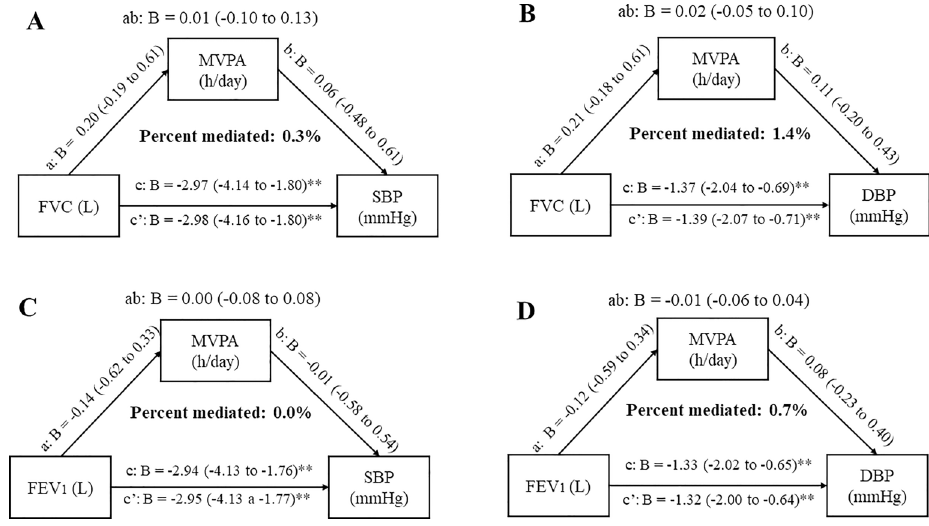
Figure 5. The mediation role of the cardiorespiratory fi tness (CRF) assessed by moderate-to-vigorous physical activity (MVPA) during a treadmill cardiopulmonary exercise testing in the correlation between ( A ) forced vital capacity (FVC) and systolic blood pressure (SBP), ( B ) FVC and diastolic blood pressure (DBP), ( C ) forced expiratory volume in the fi rst second (FEV1) and SBP, and ( D ) FEV1 and DBP. *P o 0.05; **P o